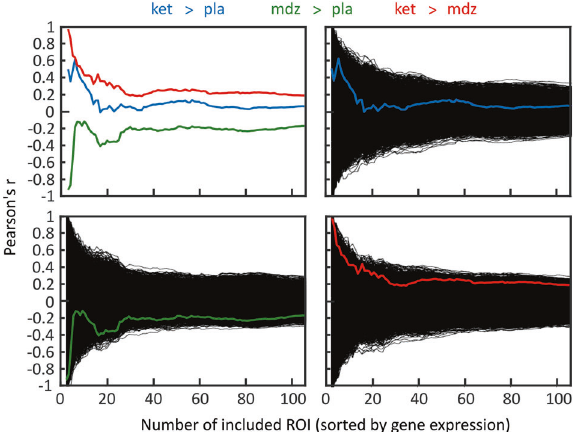
Fig. 2 Correlation between functional connectivity changes associated with the genetic variant and the different pharmaco- logical contrasts depending on the selected number of regions ranked by the expression of target genes. Connectivity changes related to the genetic variant (C-allele) are positively correlated with the contrasts ketamine > placebo as well as ketamine > midazolam and negatively correlated with the contrast midazolam > placebo. Absolute magnitude of correlation increases when iteratively removing regions with lower expression of the target genes. For the calculation of the p-values, we fi rst created a null distribution of correlation curves and the respective areas under the curves (AUCs) by applying 10,000 random permutations of the genotype variable. Then we determined the percentage of AUCs exceeding (for the contrasts ketamine > placebo and ketamine > midazolam) or falling below (for the contrast midazolam > placebo) the observed AUC. The reported p-values re fl ect the respective percentages after FDR- correction. Figure 2b, c shows the performance of the correlation curve for each pharmacological contrast as compared to the curves generated by permutation of genotype. Considering the global AUC measure, only the contrasts ketamine > midazolam and midazo- lam > placebo reached statistical signi fi cance: AUC(ketamine > pla- cebo) =